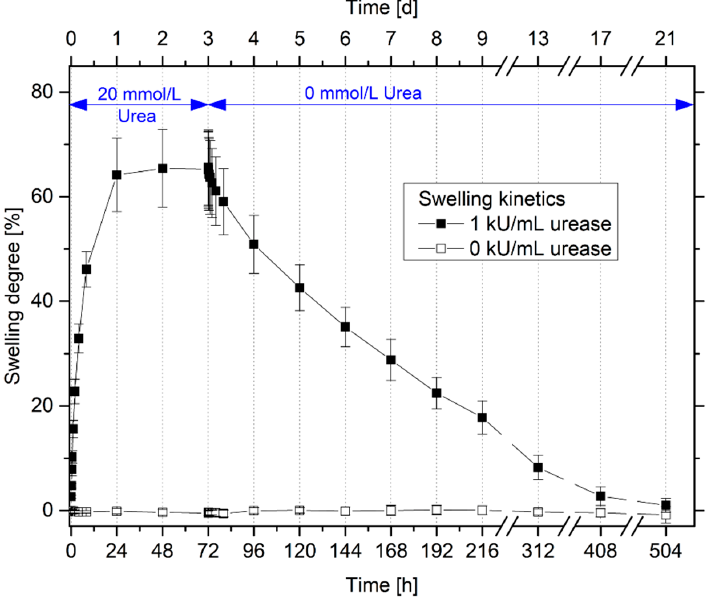
Figure 4. Swelling and deswelling kinetics of enzyme-functionalized and non-functionalized poly(AAc- co -DMAEMA) hydrogels with 20 mmol/L urea and without urea, respectively.